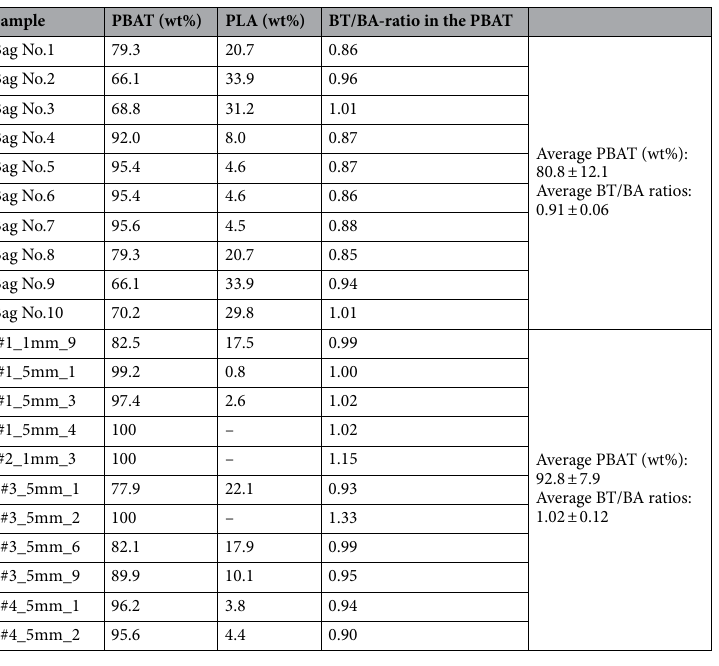
Table 2. Composition of commercial compostable bags and BDP fragments recovered from the composts as analyzed by 1 H-NMR. BT/BA-ratio in the PBAT: BT, butylene terephthalate; BA, butylene adipate, molar ratio of the two monomeric units found in the co-polyester PBAT. Fragments were coded as follows: p or f for pre-compost or finished compost, followed by the plant number (#1 to #4), an indication of the size fraction (> 5 mm or 1–5 mm) in which the fragment was found, and finally, the fragment number.